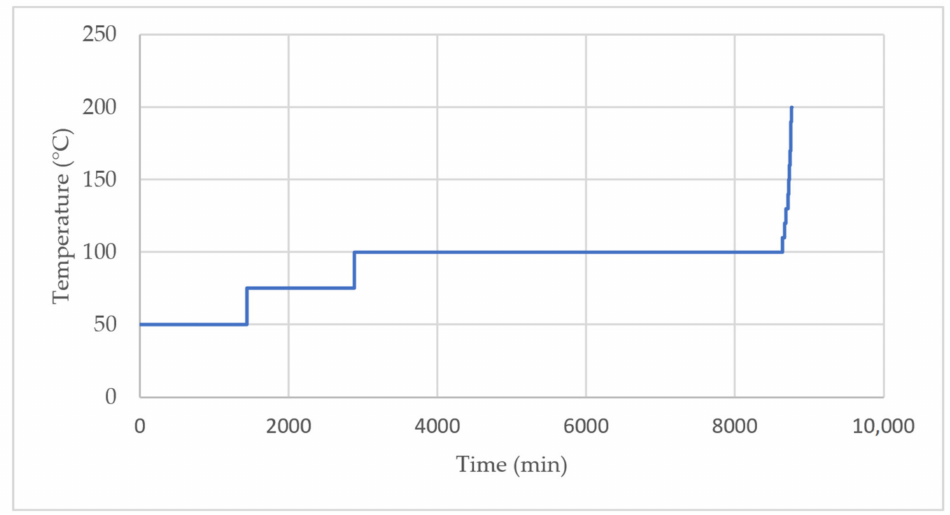
Figure 1. Temperature input timeline for thermal